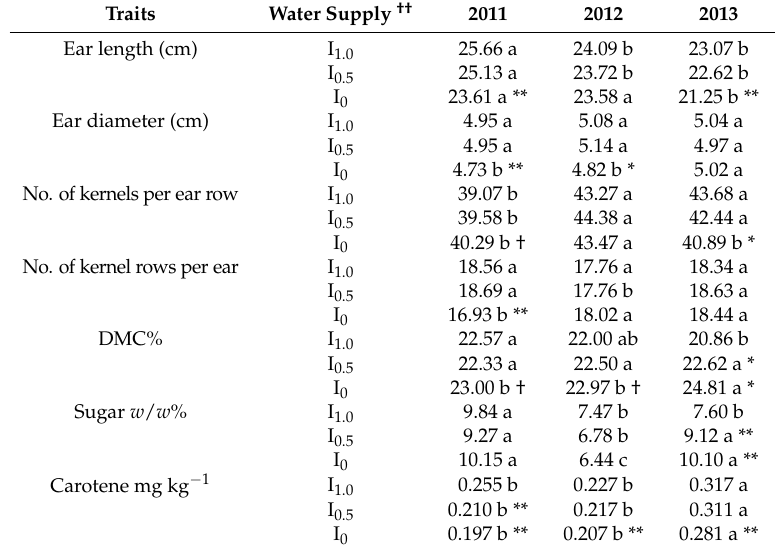
Table 2. Effect of water supply on morphological traits of ears and quality of sweet